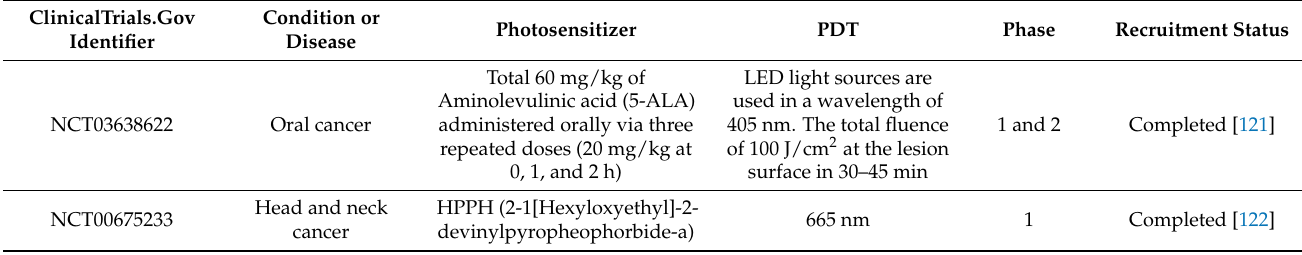
Table 3. Details of the photosensitizer and PDT parameters used in some of the global clinical trials of PDT in cancer